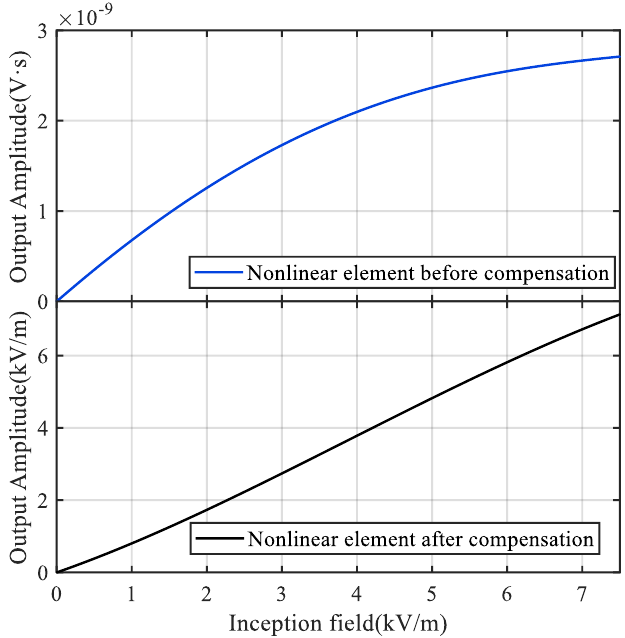
Figure 11. Nonlinear correction of the measurement system.